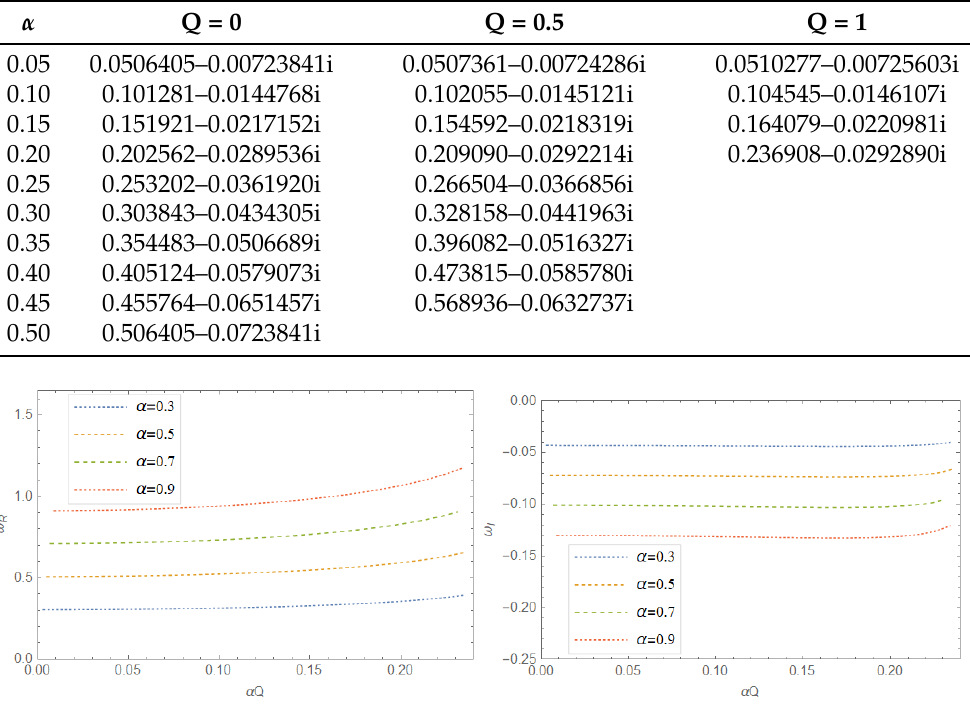
Figure 1. The real part ( left ) and imaginary part ( right ) of QNMs influenced by the parameters α and Q